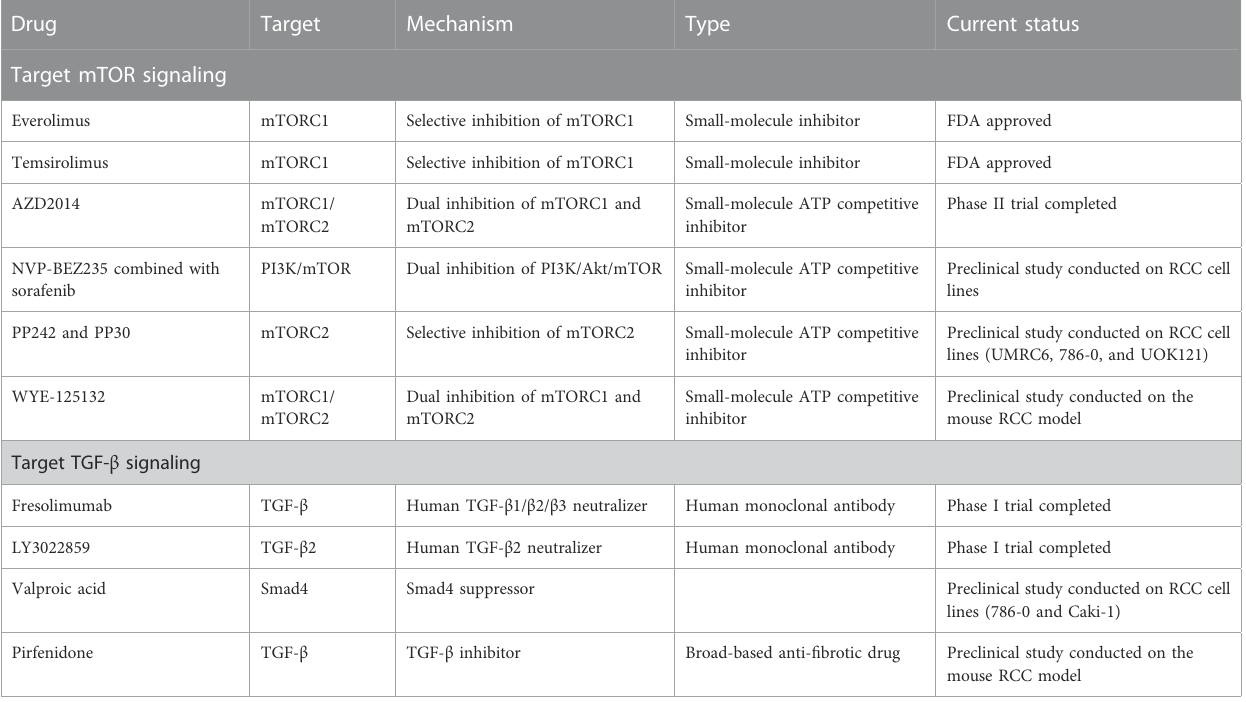
TABLE 2 Anticancer therapies targeting fi brosis in